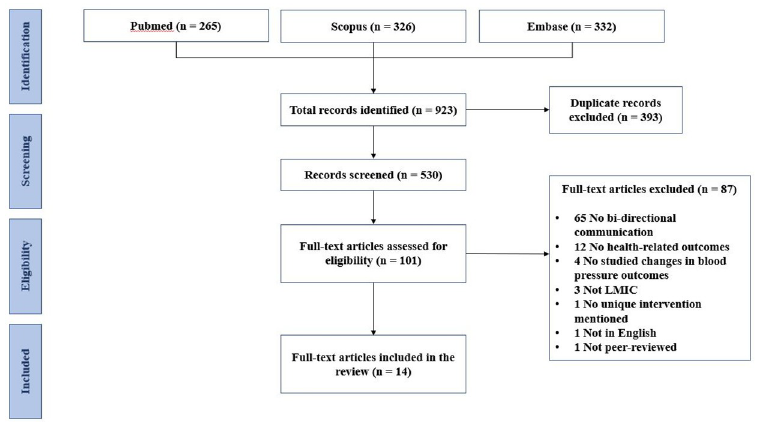
Fig 1. Flow-diagram of search